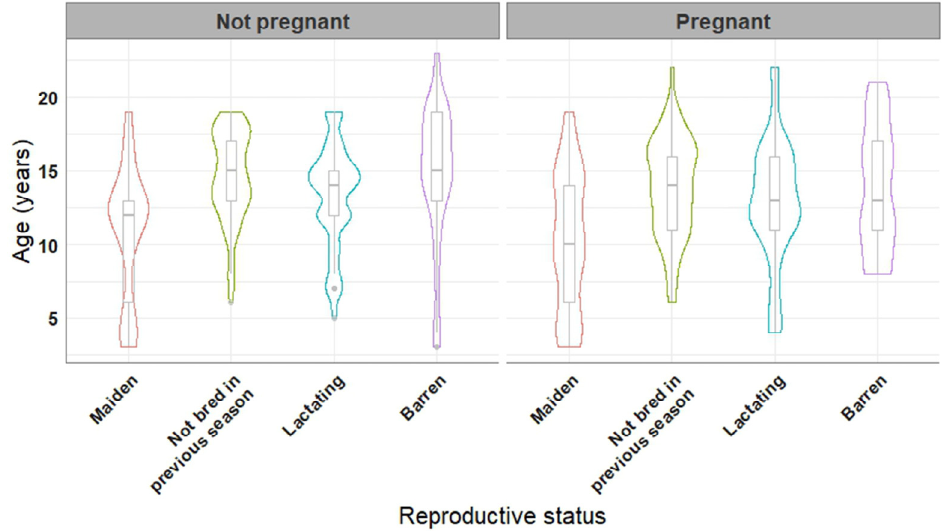
Figure 1. Violin and boxplots of the age of 220 mares in relation to their reproductive status. Mares that did not get pregnant vs. mares that got pregnant at least once during the two-year study are presented in the left and right panels of the figure, respectively.